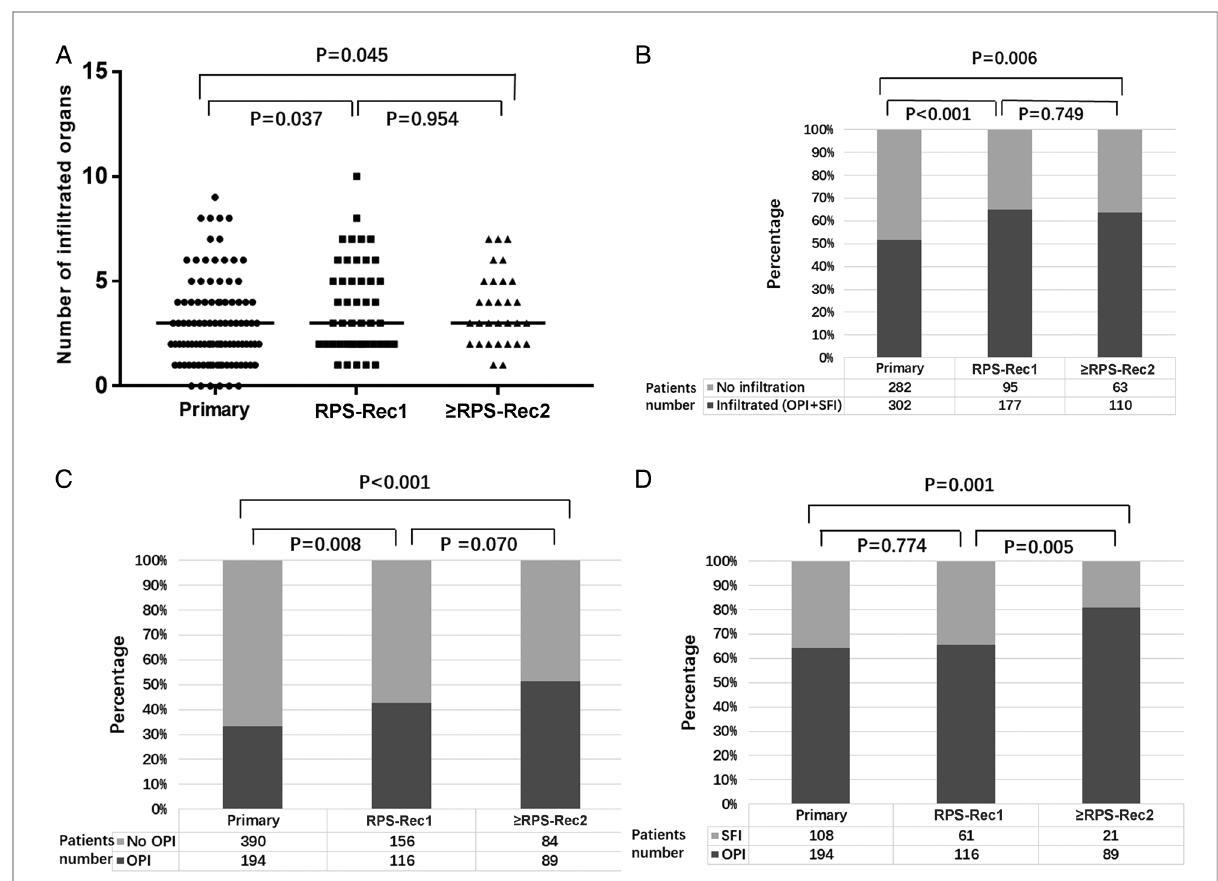
FIGURE 2 Overview of the invasion. ( A ) Number of invaded organs (including OPI and SFI) (primary vs. RPS-Rec1, P =0.037; primary vs. ≥ RPS-Rec2, P =0.045). ( B ) Percentage of invaded organs (including OPI+SFI) (primary vs. RPS-Rec1, P <0.001; primary vs. ≥ RPS-Rec2, P =0.006). ( C ) Percentage of OPI in all the resected organs (primary vs. RPS-Rec1, P =0.008; primary vs. ≥ RPS-Rec2, P <0.001). ( D ) Percentage of OPI in the invaded organs (including OPI and SFI) (primary vs. RPS-Rec1, P =0.774; primary vs. ≥ RPS-Rec2, P =0.001). Black lines indicate median values. OPI, organ parenchyma invasion; SFI, surrounding fat